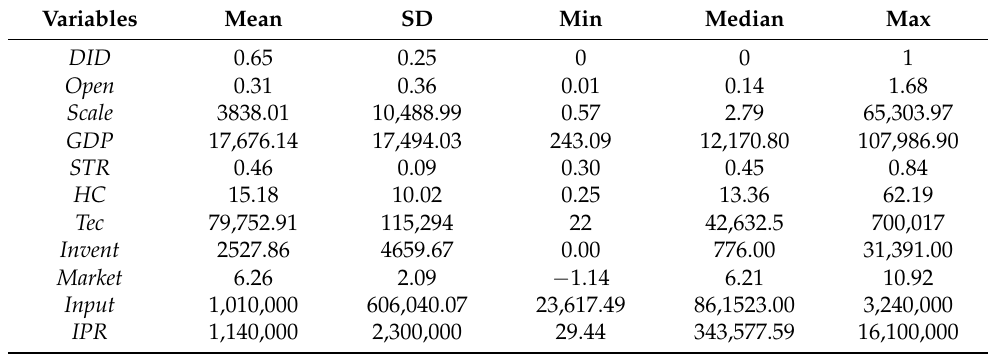
Table 1. Descriptive